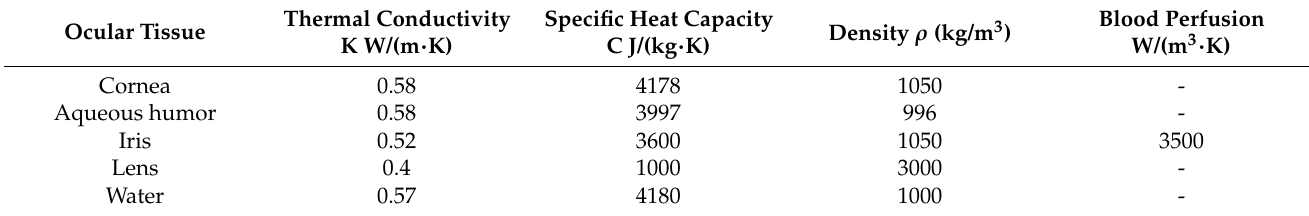
Table 2. The thermal properties of ocular tissues used in the FDTD simulations